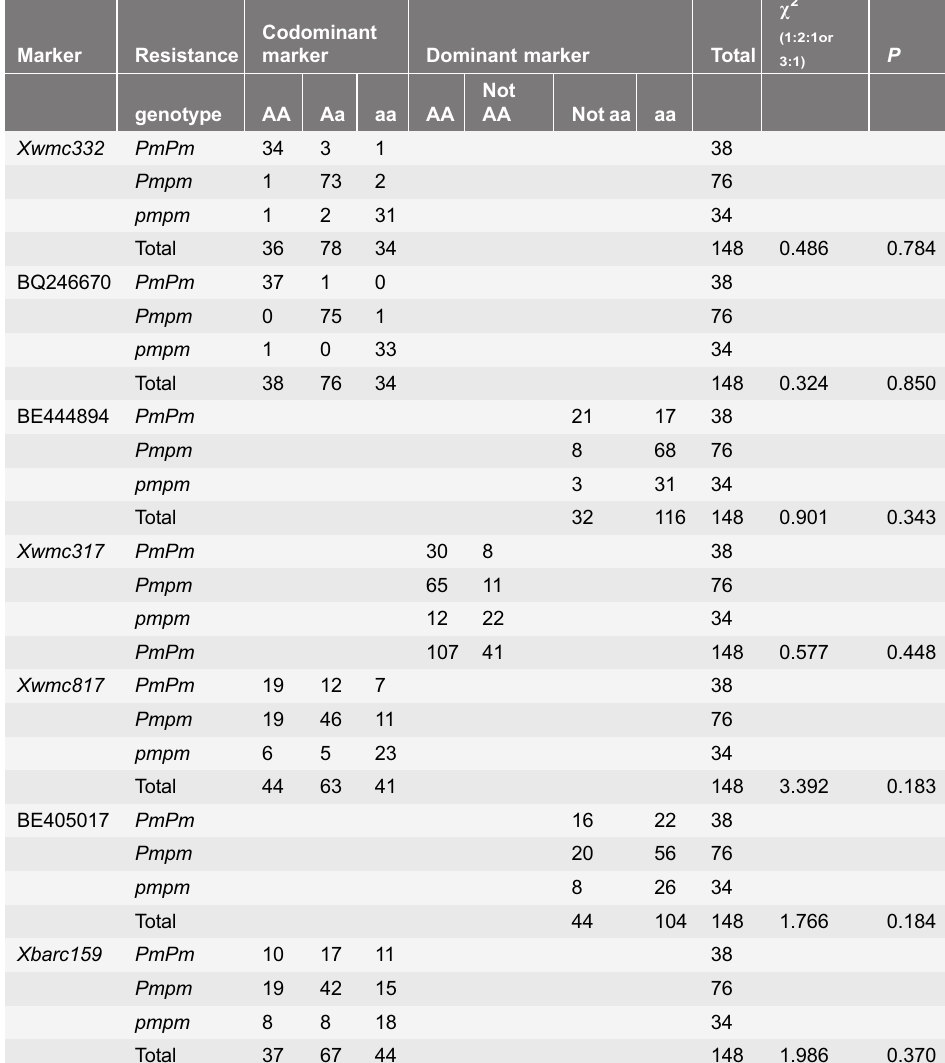
AA homozygous for the CH7086 allele; aa homozygous for the CH5241 allele; Aa heterozygous. a The data of F 2:3 lines from CH5241/CH7086; b Values for significance of x 2 at P 5 0.05 is 3.84 for 1 df and 5.99 for 2 df ,